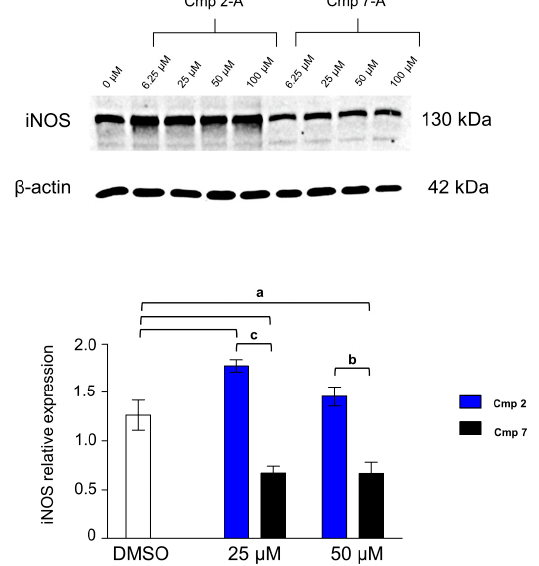
Figure 8. Inducible nitric oxide synthase (iNOS) expression levels in tendon-derived cells pre-incubated with hydrogen peroxide (H 2 O 2 ) in the presence of Cmp 2 and Cmp 7 . Data are reported as means ± standard deviations of independent experiments with the three donors pooled (n = 9). Western blot analysis of the iNOS expression in tenocytes pre-incubated with H 2 O 2 100 µ M for 3 h and exposed as indicated for 24 h. β -actin is used as a loading control. The bar graph displays densitometric values expressed as mean DOI normalized on the ones of the loading control. a = p < 0.01; b = p < 0.001; c = p < 0.0001 between samples and DMSO alone. DMSO = cultures pre-incu- bated with H 2 O 2 and treated with DMSO 0.2%.